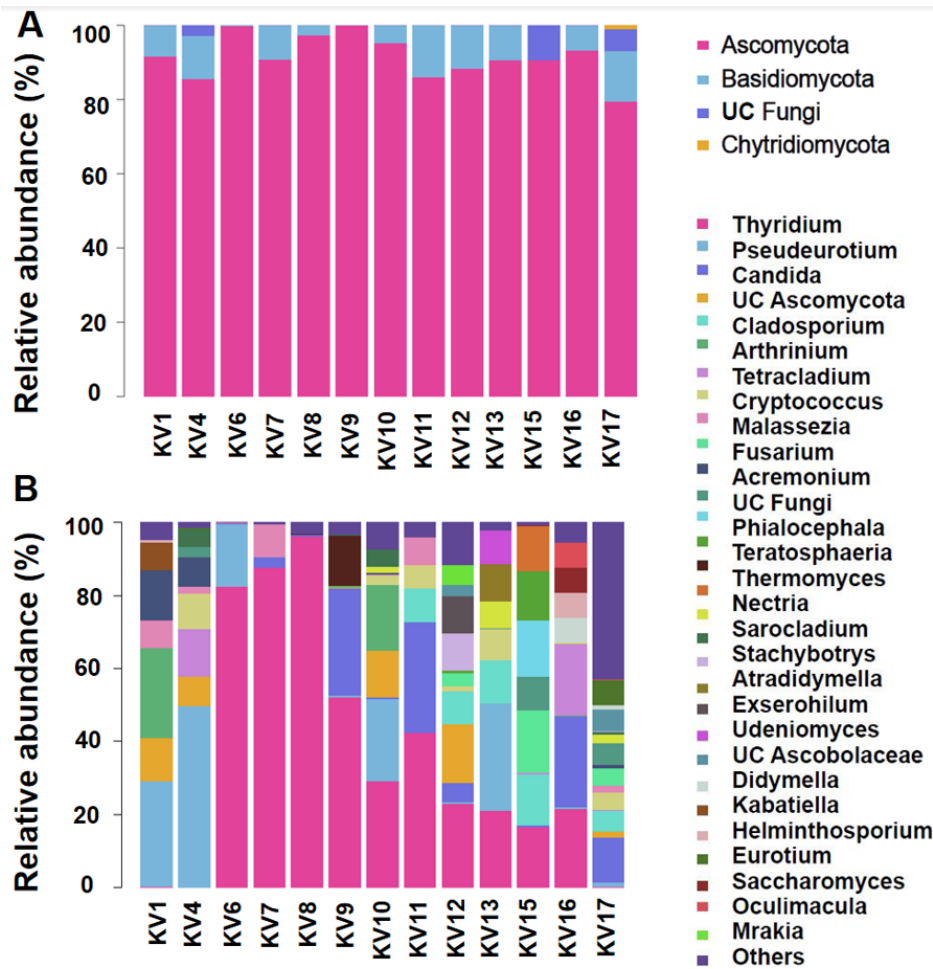
Figure 2. Relative abundance of fungi at ( A ) phylum and ( B ) genus (top 30) levels. Abundance is presented as a percentage of total effective ASVs in the samples. UC: unclassified. Table 1. Occurrence and abundance of 15 abundant genera (relative abundance > 1% in all samples as a whole) in 13